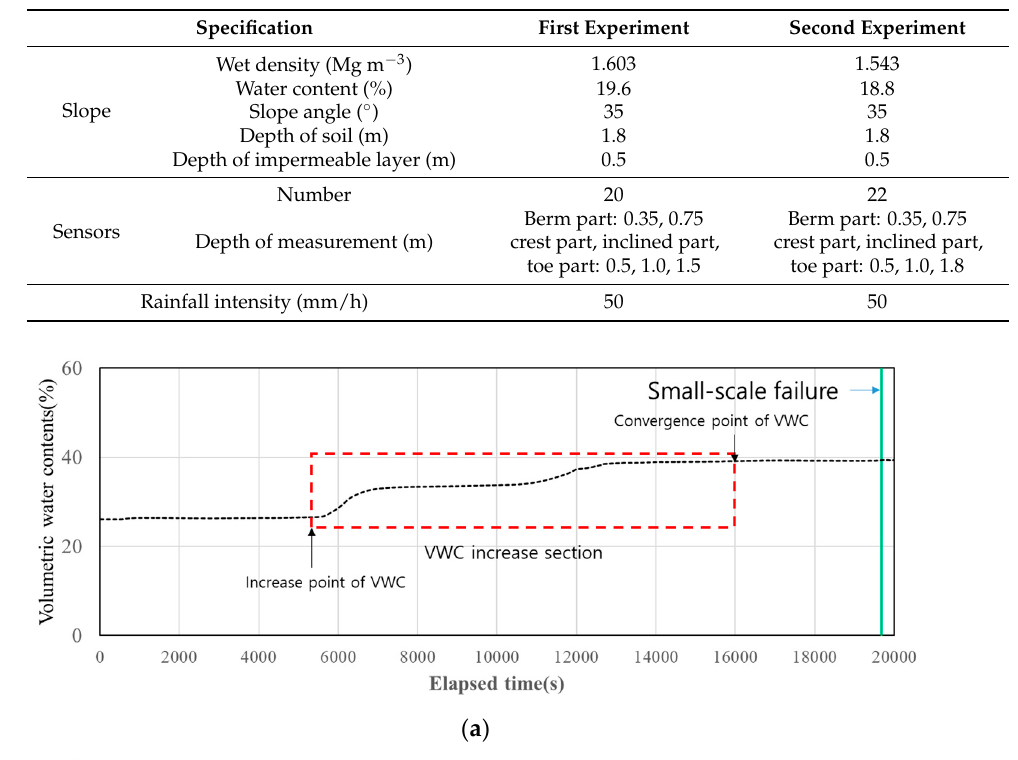
Table 5. Soil condition and positions of sensors for full-scale flume experiments.